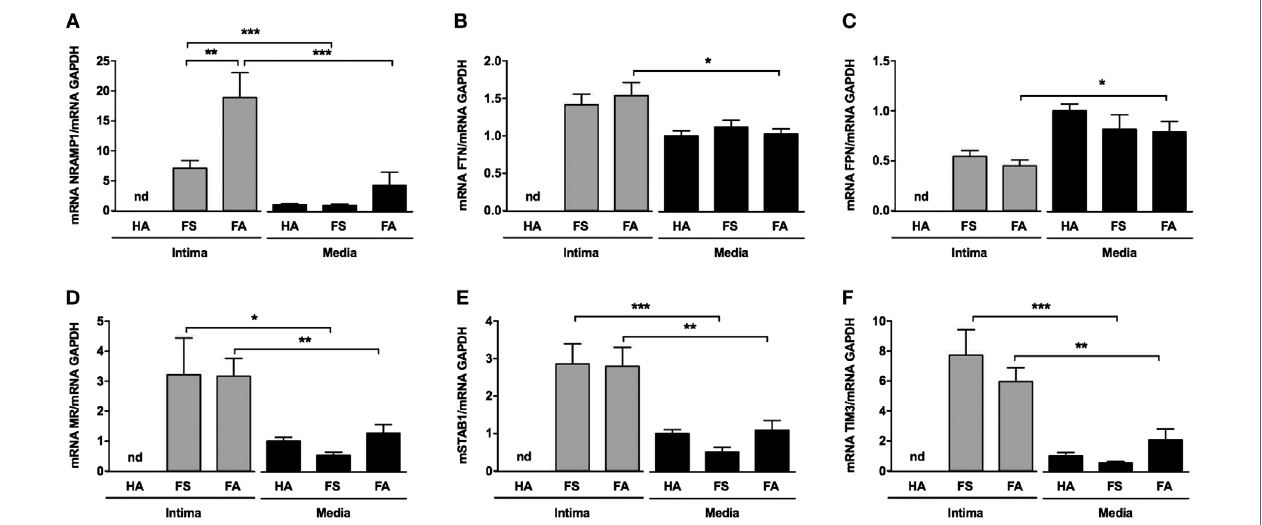
FigUre 5 | Intraparietal red blood cells are associated with iron storage and expression of scavenger receptors. (a–c) mRNA levels of the following iron metabolism genes: NRAMP, ferritin, and ferroportin [ (a–c) , respectively]. (D–F) mRNA levels of the following phagocytosis genes: stabilin-1, mannose receptor (MR), and TIM3 [ (D–F) , respectively]. These quantifications were performed from mRNA isolated from the tunica medias of healthy aortas (HAs, n = 10) and from the tunica intimas ( n = 10) and tunica medias ( n = 10) of fatty streaks and fibroatheromas (FAs). * p < 0.05; ** p < 0.01; *** p < 0.0001 (Mann–Whitney’s